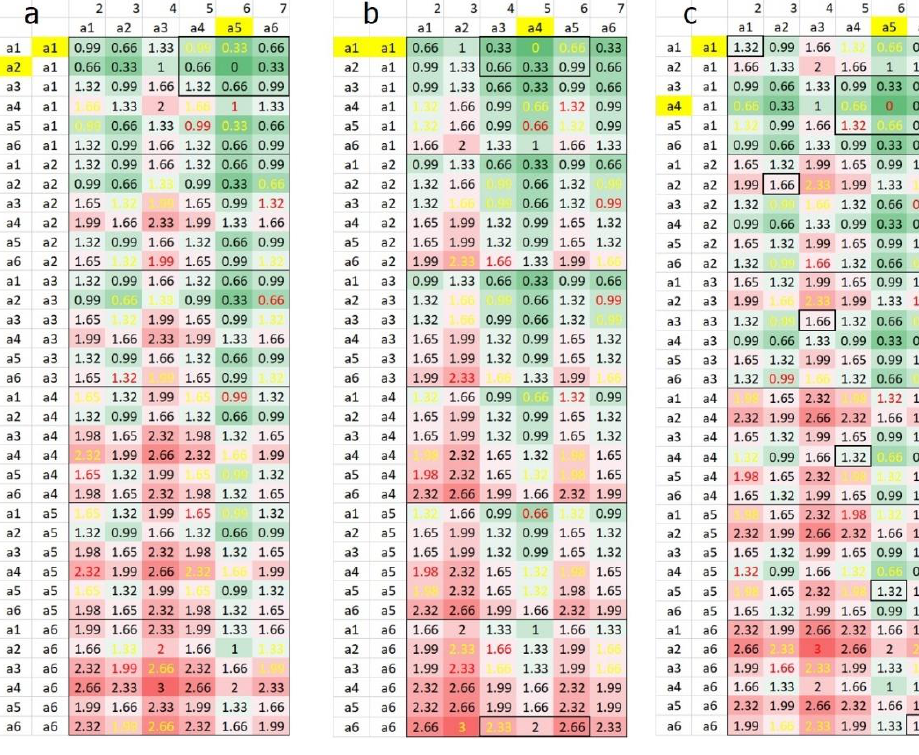
Figure 28. Conflict heatmap with the Kendall Tau method. ( a ) Conflict map for the pivot point (a2, a1, a5), ( b ) Conflict map for the slack point (a6, a6, a4) and ( c ) Conflict map for the pivot point (a4, a1, a5)